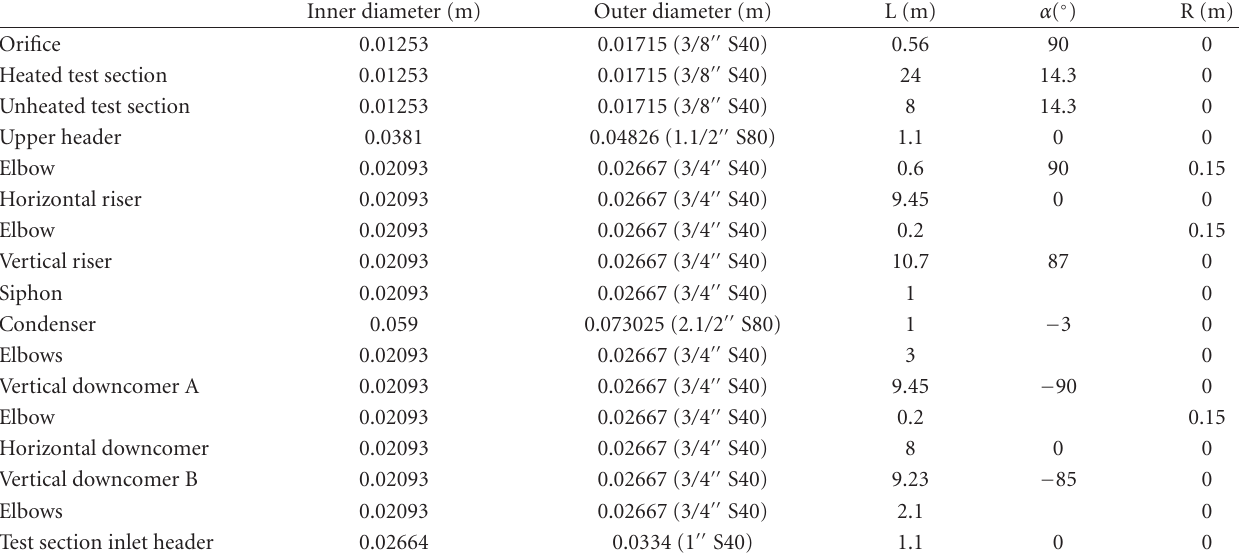
Table 1: IES facility main geometrical data .